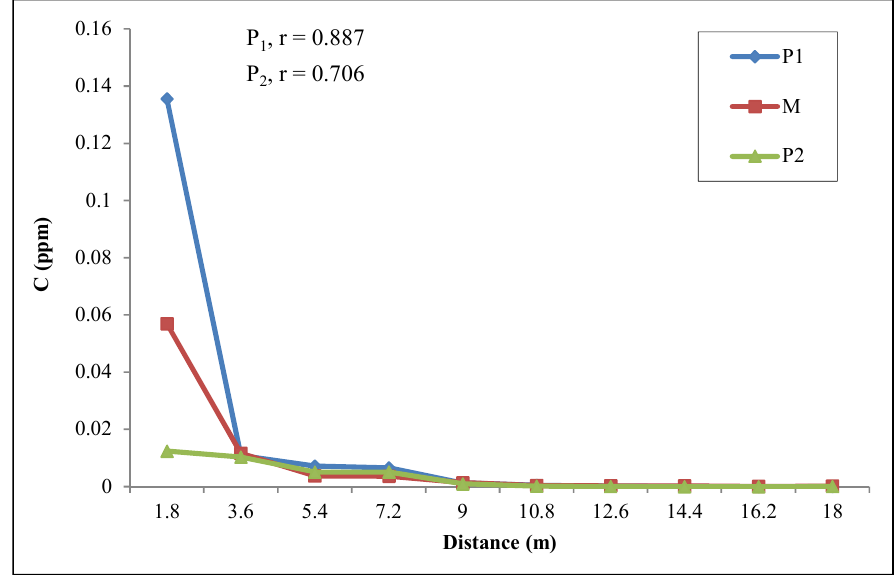
Figure 6. Measured and Predicted Concentrations against Distance for the month of